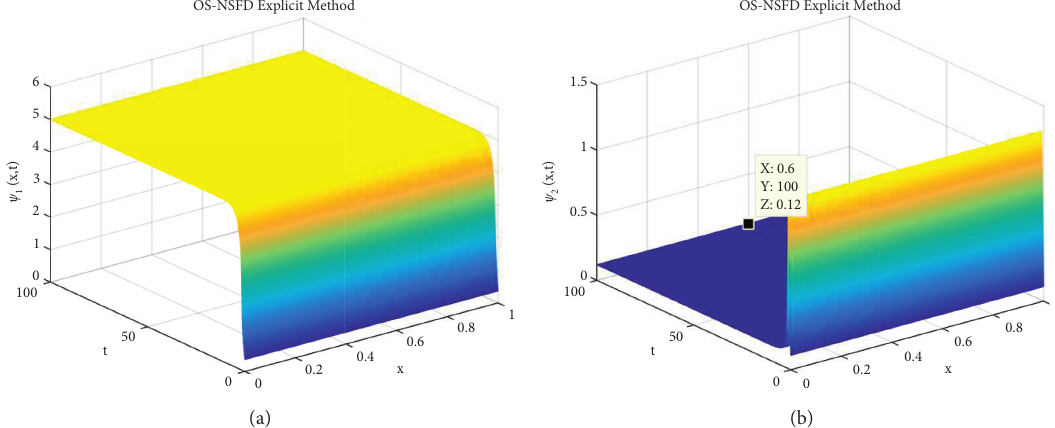
Figure 16: Mesh graphs of ψ Mesh graph of ψ